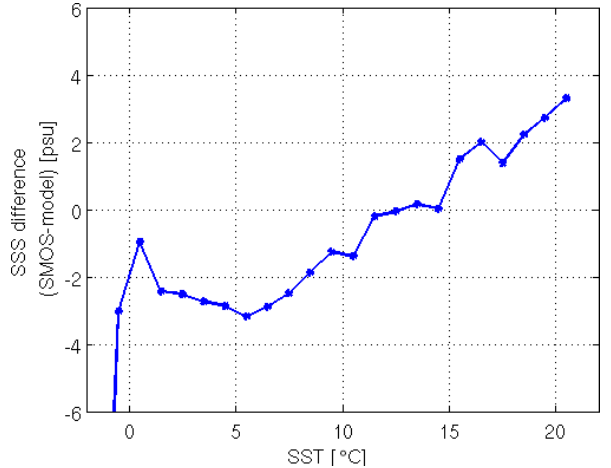
Figure 5. Difference between the SMOS SSS and reanalysis salin- ity variability as a function of the